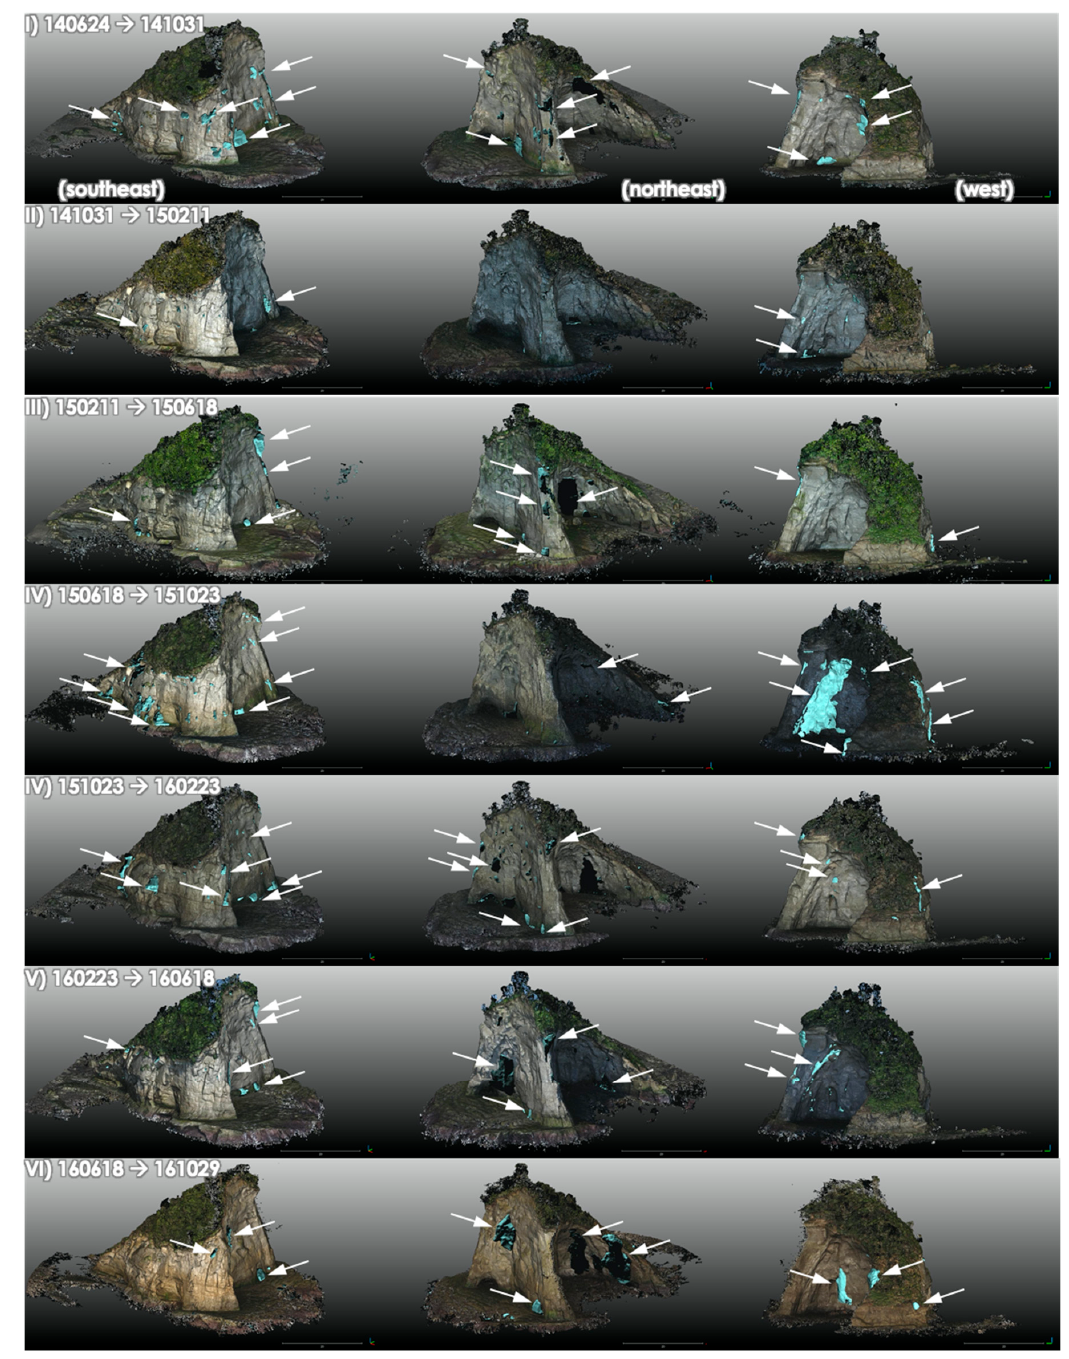
Figure 6. Differential volume estimate (DVE) for each time period, showing the eroded area of the Figure 6. Cont bedrock cliffs by comparing the point clouds taken in different time periods. Changed areas are highlighted with white arrows.